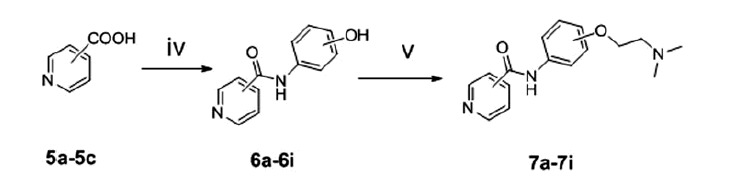
Synthesis of picolinamide amide derivatives. Reagents and conditions: (iv) aminophenol, DCC, HOBT, toluene, RT; (v) (CH3)2 N(CH2)2Cl2, K2CO3, NaI, acetone, reflux.